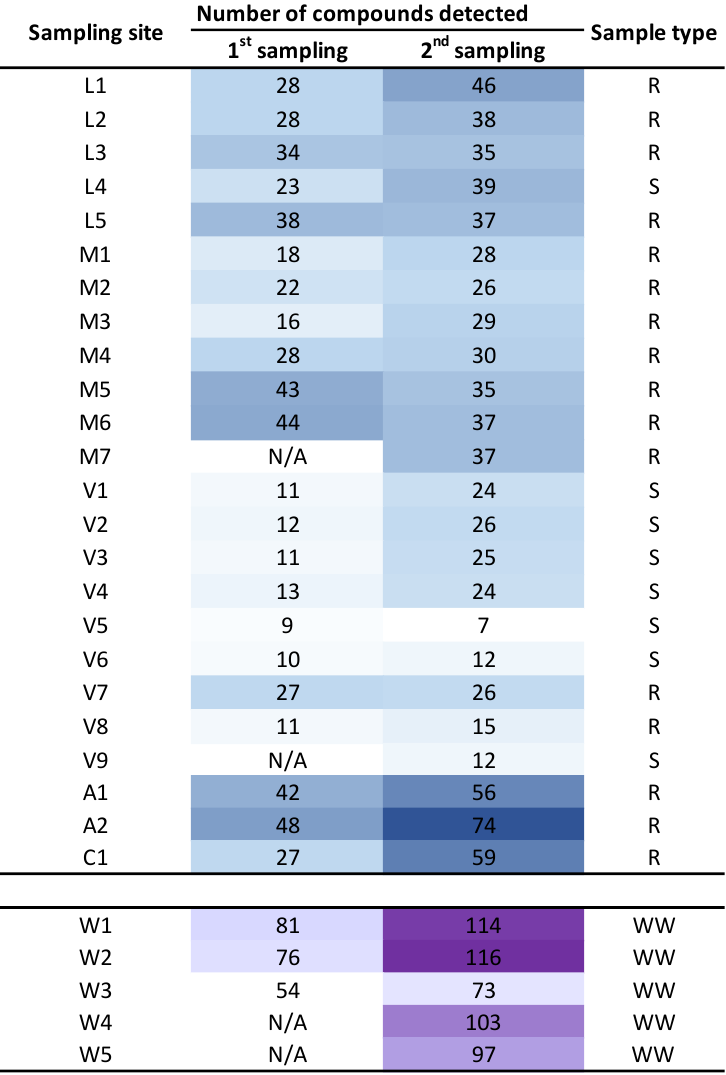
Figure 3. Heat map of number of compounds identified per sampling site and campaign. Sample type code: river water (R), sea and transitional water (S) wastewater (WW). First sampling was held during January–February 2020 and the second sampling was held during June–July 2020. No POCIS sampling is considered. N/A (not